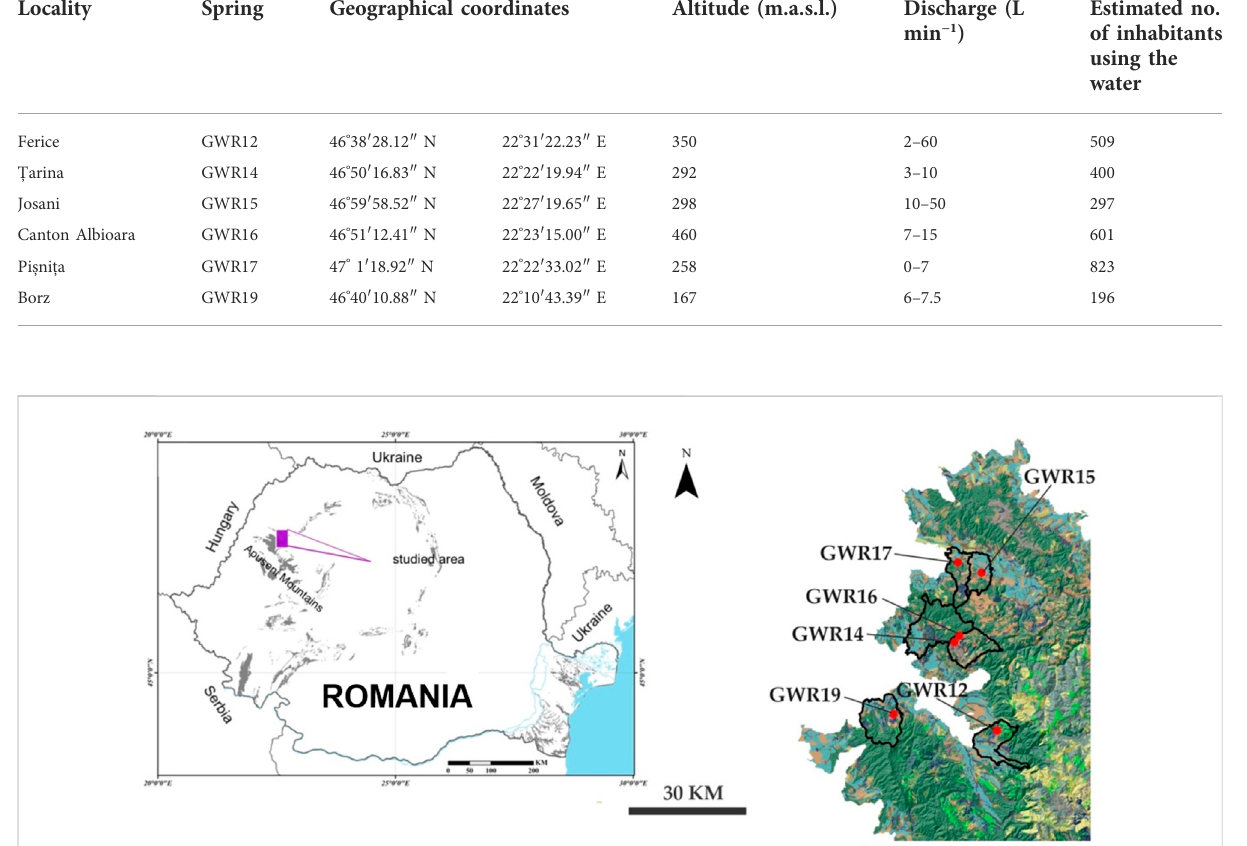
TABLE 1 Karst water springs with their geographical coordinates and the estimated number of inhabitants relying on these waters. Locality